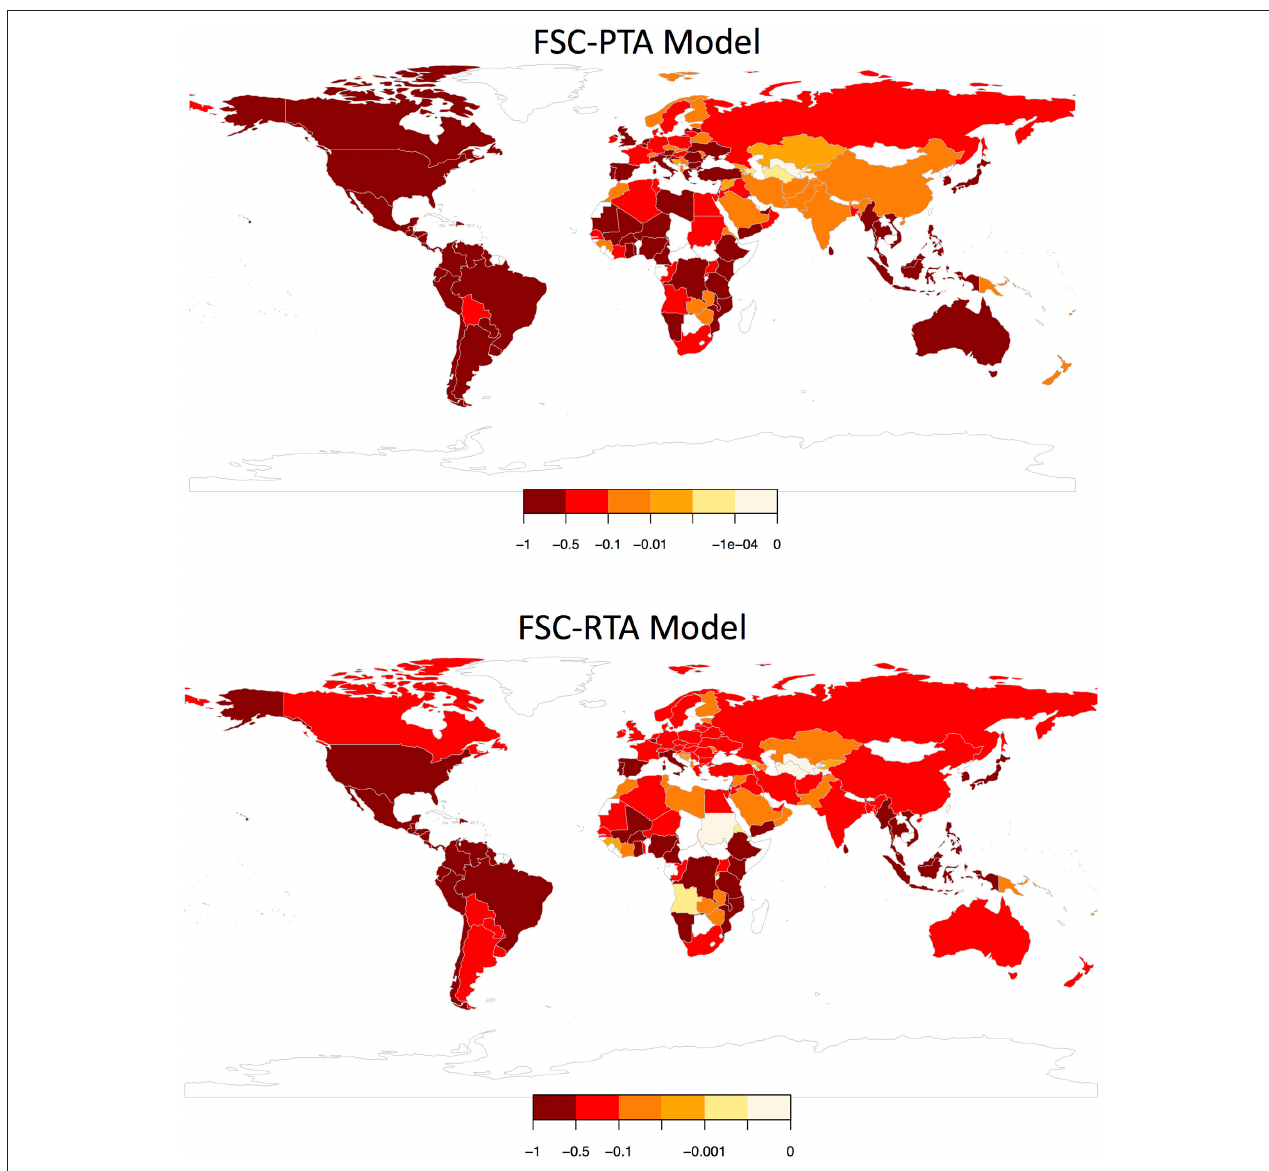
FIGURE 3 | Total fractional change in reserves relative to initial reserves for the FSC-PTA and FSC RTA